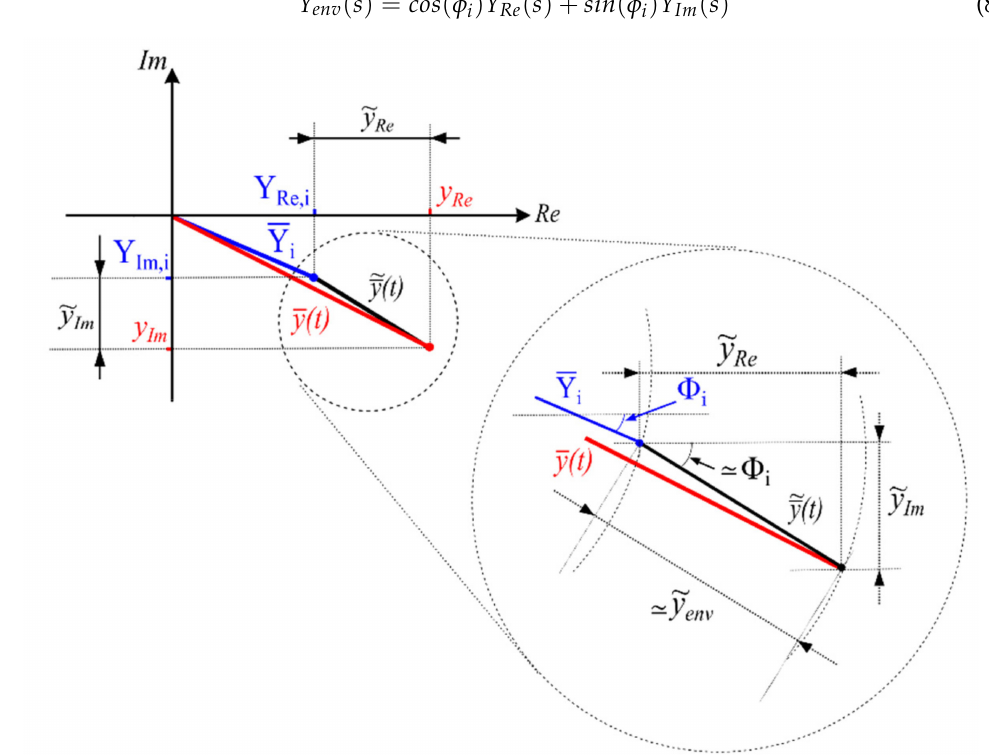
Figure 4. Graphical explanation of the linearization process for Equation